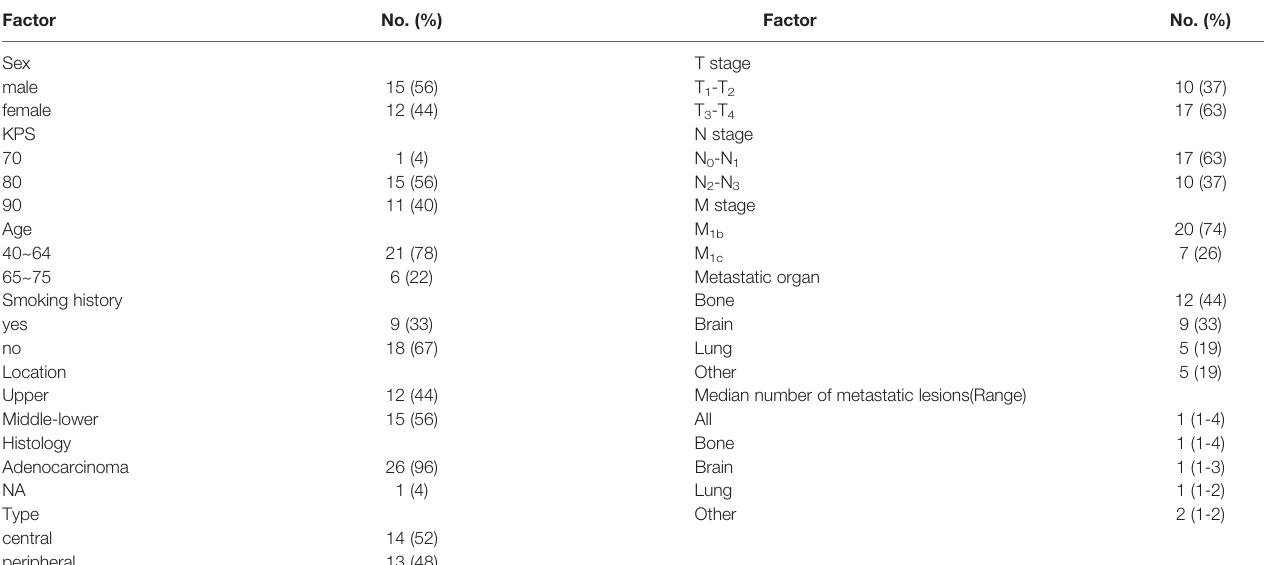
TABLE 1 | Clinical characteristics of 27